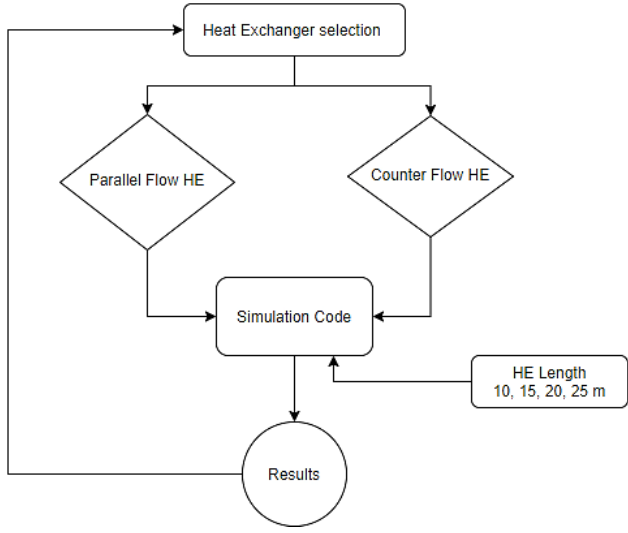
Figure 3. Research Methodology